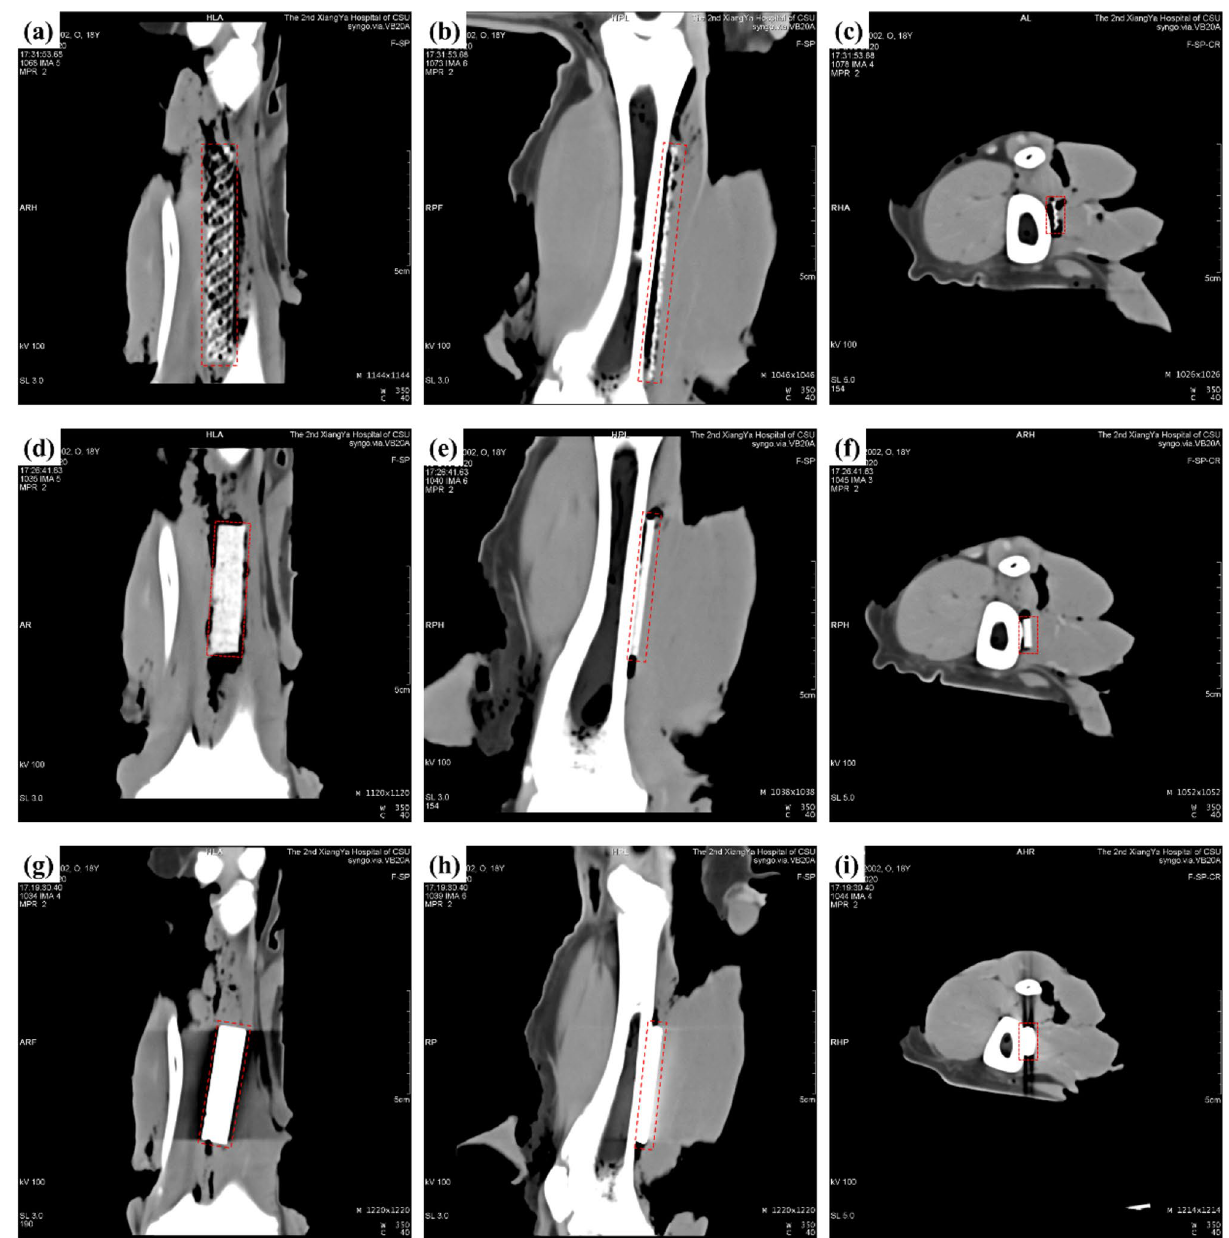
Figure 6. CT images of materials implanted into the shinbone of pig legs (Sample is in the dotted circle), ( a – c ) for 3D-C/C composites, 80 × 12 × 3.4 mm in dimension; ( d – f ) for 2.5D-C/C composites, 55 × 12 × 3.4 mm in dimension; ( g – i ) for TC4, 55 × 12 × 3.4 mm in dimension, 3D-C/C composites artificial rib is implanted, there is obvious tissue growth inward and capsule formation. Moreover, the implantation does not cause obvious inflammatory reaction of surrounding soft tissues and dense adhesion. Figure 7 is a picture of soft tissue sections at 3D-C/C composites artificial rib/rib junction and 3D-C/C com- posites site after implantation in dogs for 1 year. There is no obvious hyperplasia and inflammatory reaction in soft tissue. The tissue is loose, the layers are clear, and there is no obvious vascular hyperplasia. It then could be concluded that 3D-C/C composites artificial rib is suitable for chest wall reconstruction.